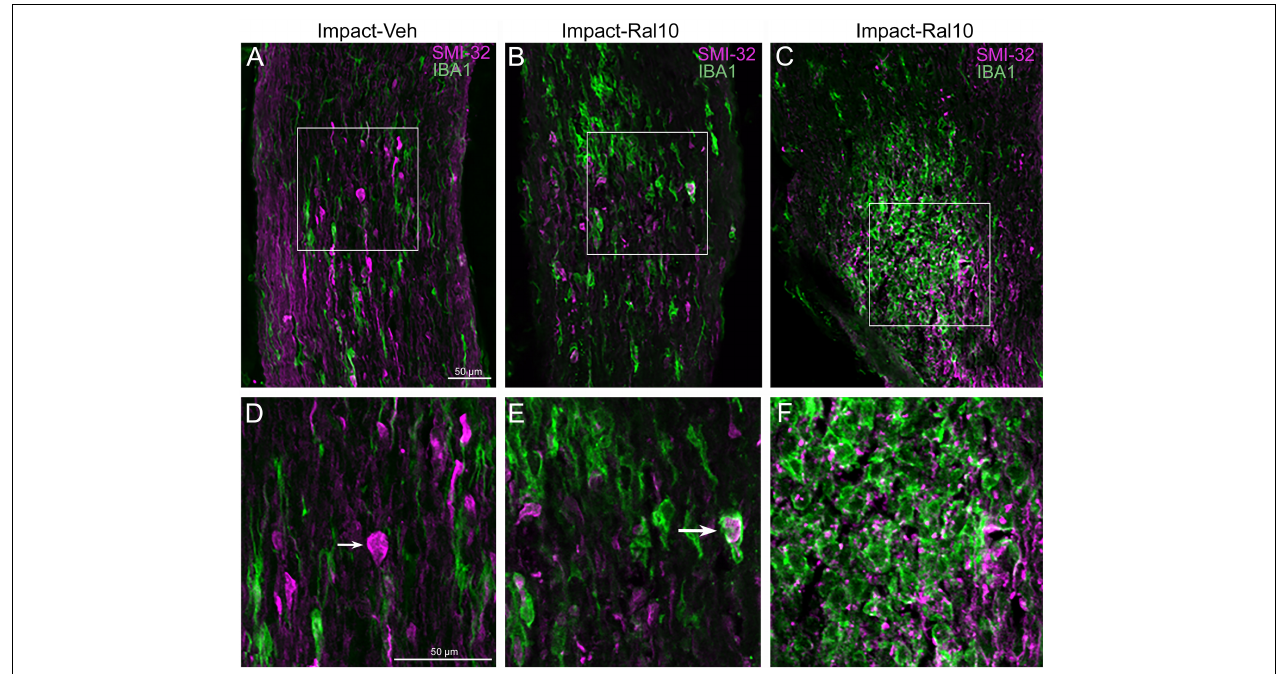
FIGURE 6 | Axon injury and microglial activation in the optic nerve. Confocal images of optic nerve sections from mice 3 days after impact TBI, taken from the region just beyond the extraocular muscle cone, immunostained with SMI-32 to detect injured axons and for IBA1 to reveal microglia. (A) Large SMI-32+ axon bulbs (magenta) and intensely stained microglia (green), indicative of injury to the nerve, are visible in the image from an impact-vehicle mouse. Note that, by contrast, in sham mice, axon bulb pathology is absent (and thus not shown here) and microglia are lightly labeled for IBA1 (see Figure 7A ). (B) Microglia with more rounded shapes are present in impact mice treated with 10 mg/kg raloxifene, one of which appears to be engulfing an axon bulb. (C) Numerous microglia are seen clustered together, amidst a field of small SMI-32+ profiles that resemble debris from degenerating axons. (D–F) Higher-magnification views of the regions shown boxed in (C) . The small arrow in (D) marks an especially large axon bulb. The larger arrow in (E) indicates a rounded microglial cell that appears to be engulfing an axon bulb. Scale bar in (A) applies to (A–C) , and scale bar in (D) applies to (D–F)